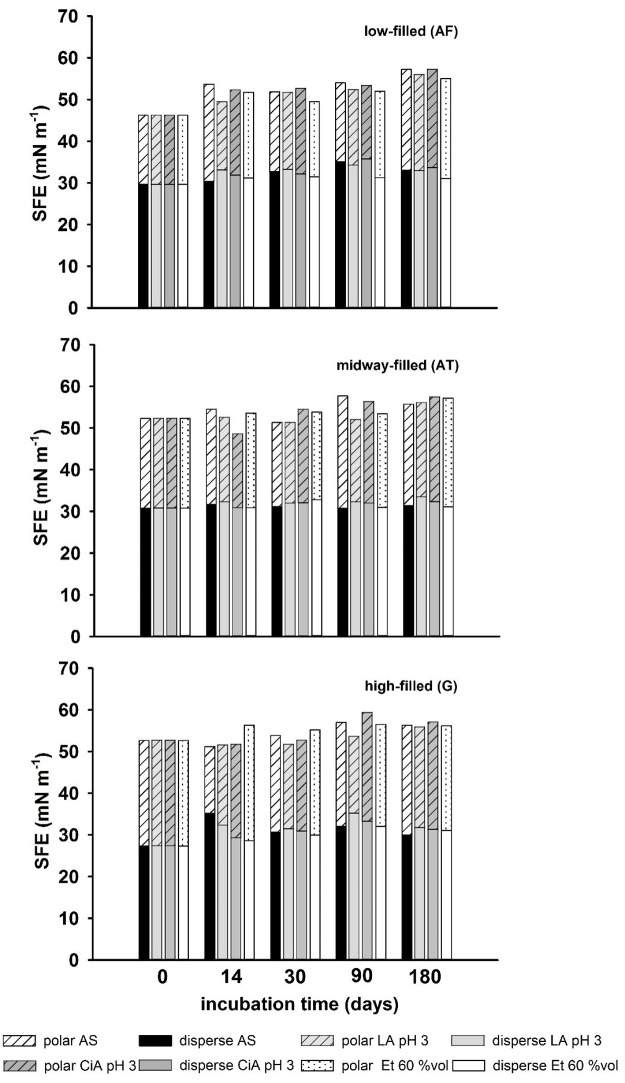
SFE with polar and disperse fractions over incubation time.